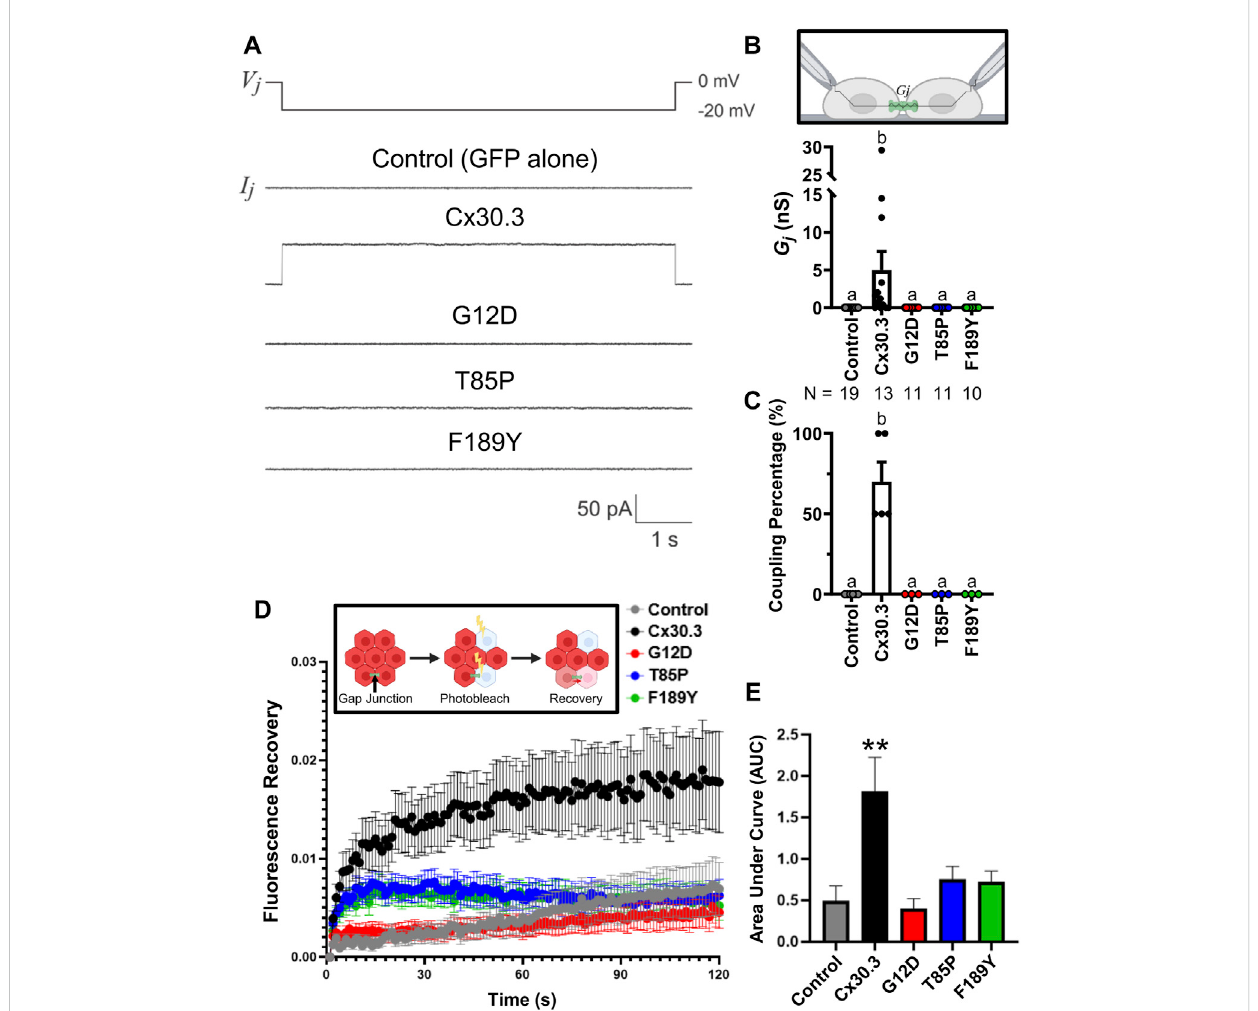
FIGURE 5 Cx30.3 mutants do not form functional gap junctions. (A) Representative recordings of junctional currents ( I j ) following a − 20 mV trans-junctional voltage pulse ( V j ) in N2a cells expressing GFP-tagged wild type or mutant Cx30.3, or free GFP (Control). (B) Quanti fi cation of macroscopic junctional conductance ( G j ) indicates that N2a cells expressing wild type Cx30.3 form functional gap junctions, while control (GFP alone) and mutant-expressing cellsdonot.Nvalues belowthegraphrepresents thenumber ofcell pairsexpressingeachmutantanalyzed. (C) Analysisofthecouplingpercentage of control N2a cells or N2a cells expressing GFP-tagged wild type or mutant Cx30.3. (D) Fluorescence recovery in Cx43KO REKs, mediated by junctional transfer of unbleached calcein red-orange dye from coupled cells, was monitored over 120 s. (E) Quanti fi cation of the area under the curve reveals